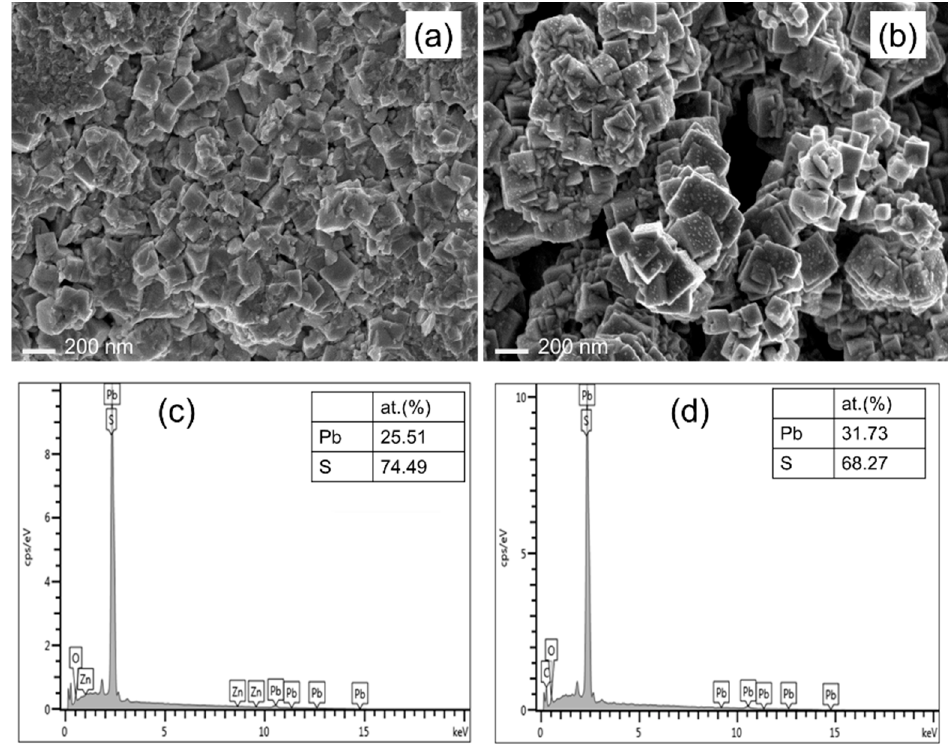
Figure 4. ( a ) and ( b ) SEM images and ( c ) and ( d ) EDX spectra of PbS nano-particles synthesized Figure 4. ( a , b ) SEM images and ( c , d ) EDX spectra of PbS nano-particles synthesized via plant-extract via plant-extract supported method, ( a ) and ( c ) is for 300 °C and ( b ) and ( d ) for 360 °C of calcina- supported method, ( a , c ) is for 300 ◦ C and ( b , d ) for 360 ◦ C of calcination tion temperature.